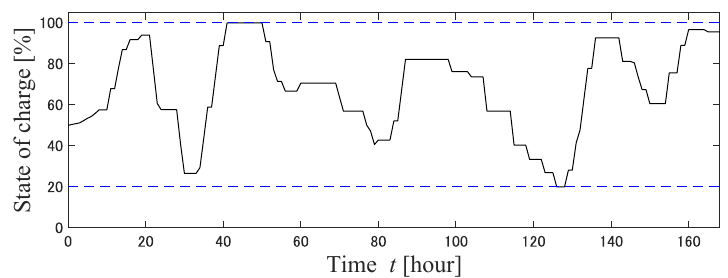
Figure 24. Generated power and load from January 1 to 7 (Case 2).